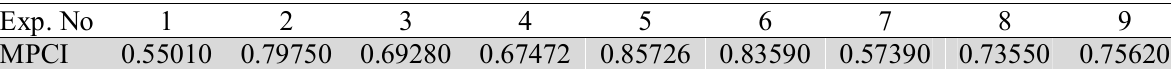
Results of MPCIs